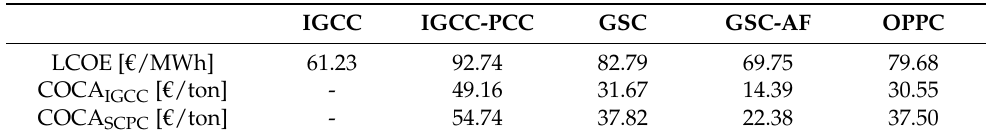
Table 9. LCOE and COCA indicators for each case.